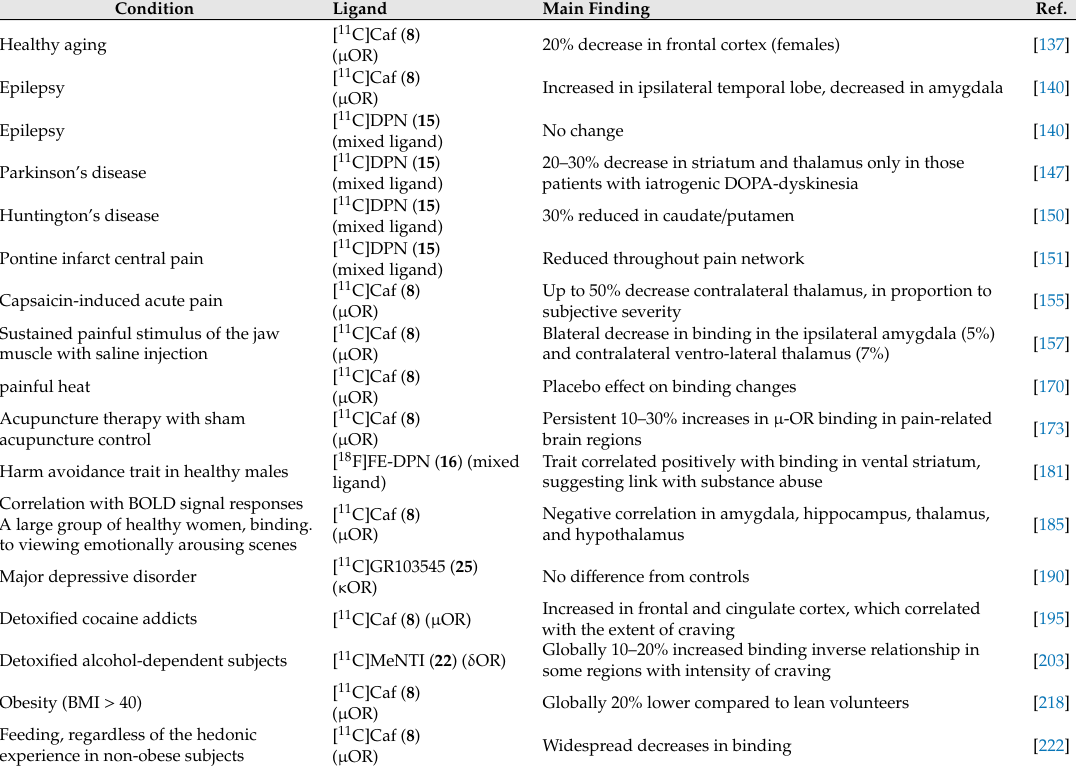
Table 2. A summary of the key results with opioid PET in clinical